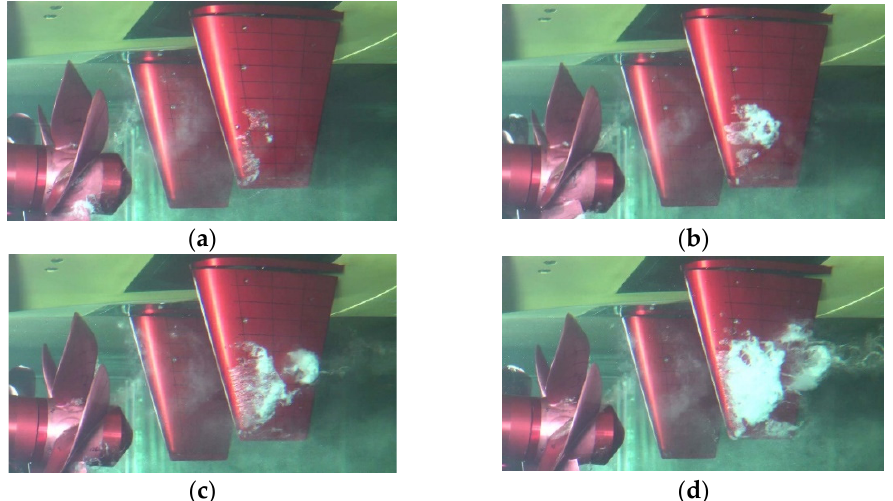
Figure 19. Cavitation observation of flat-type rudder with the variation of its deflection angle in the large cavitation tunnel (experiment). ( a ) 0°, ( b ) − 2°, ( c ) − 4°, and ( d ) − 8°.